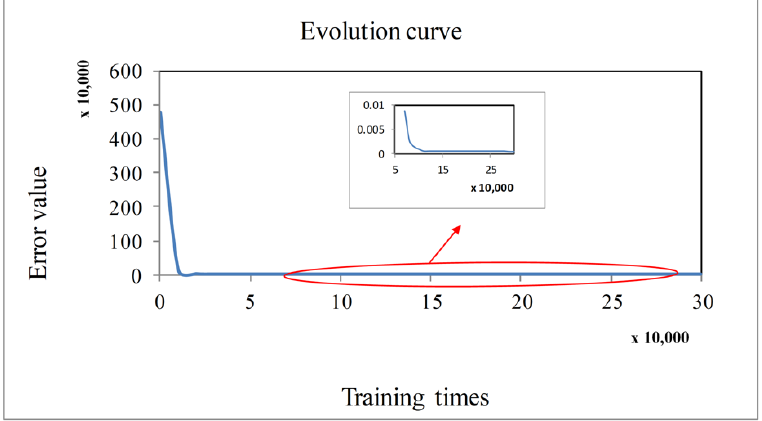
Figure 4. Error evolution curve of BP neural network.